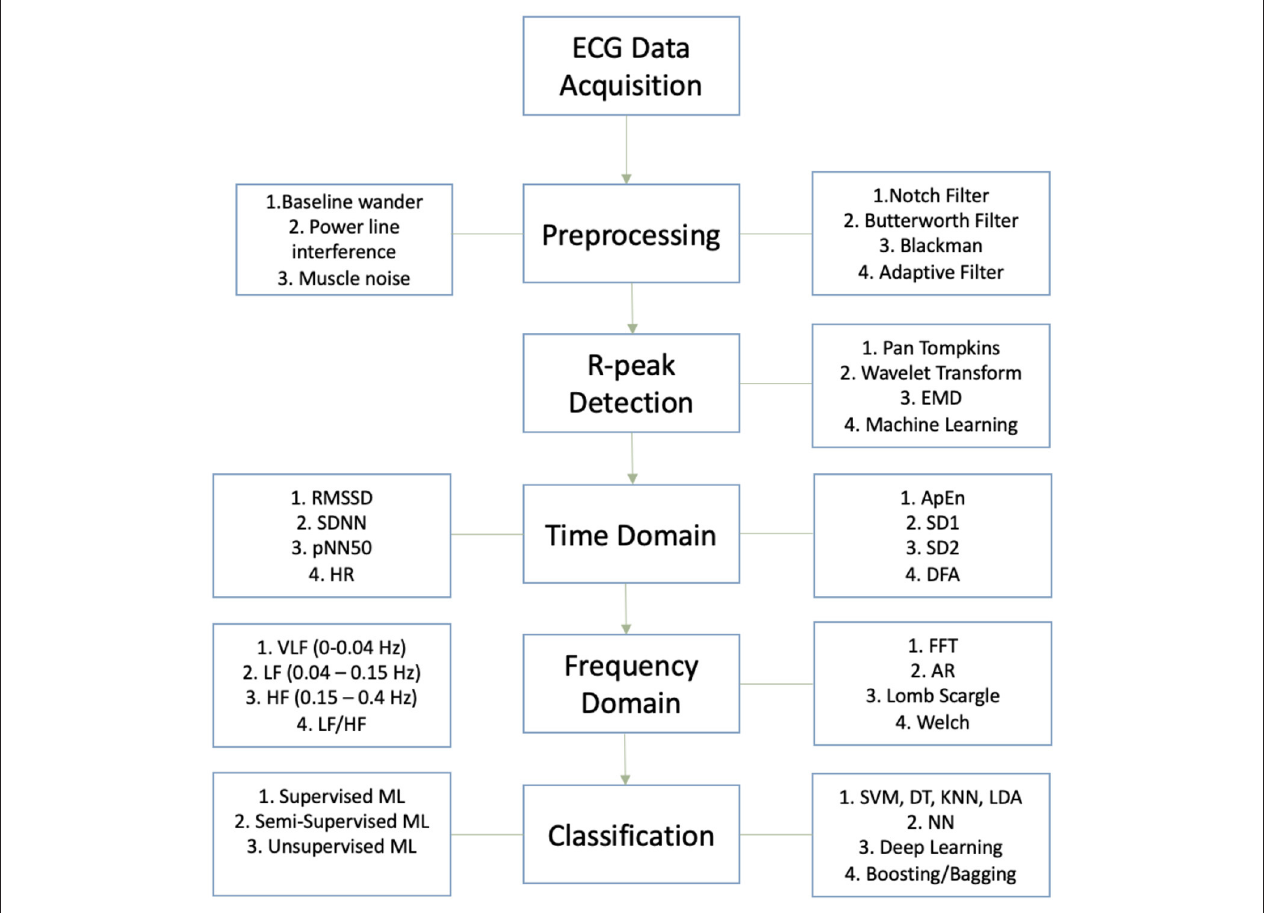
FIGURE 6 | Process flow chart for HRV analysis and